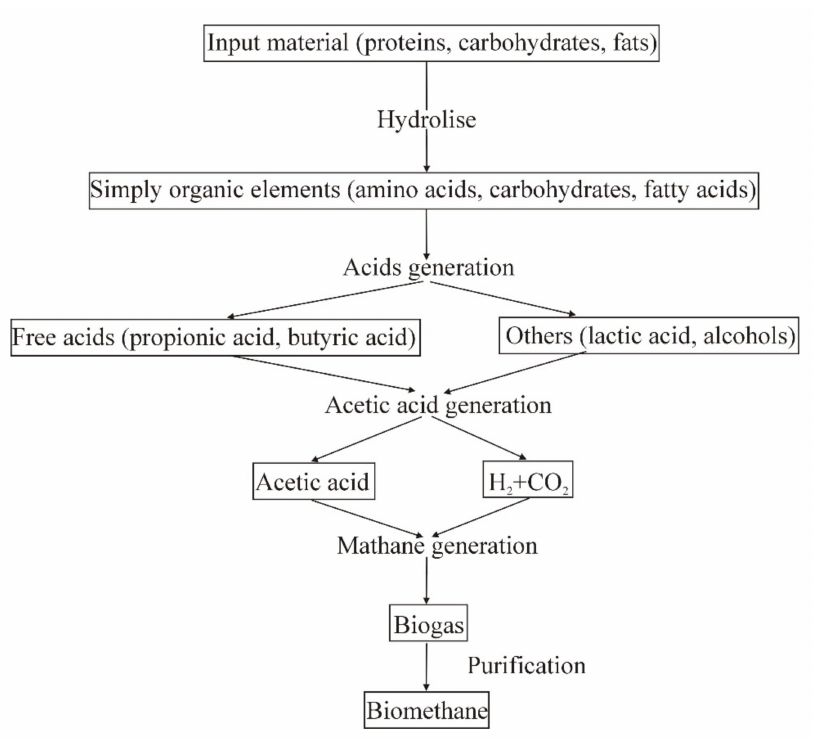
Figure 2. Scheme of the fermentation process for BM production; own elaboration based on